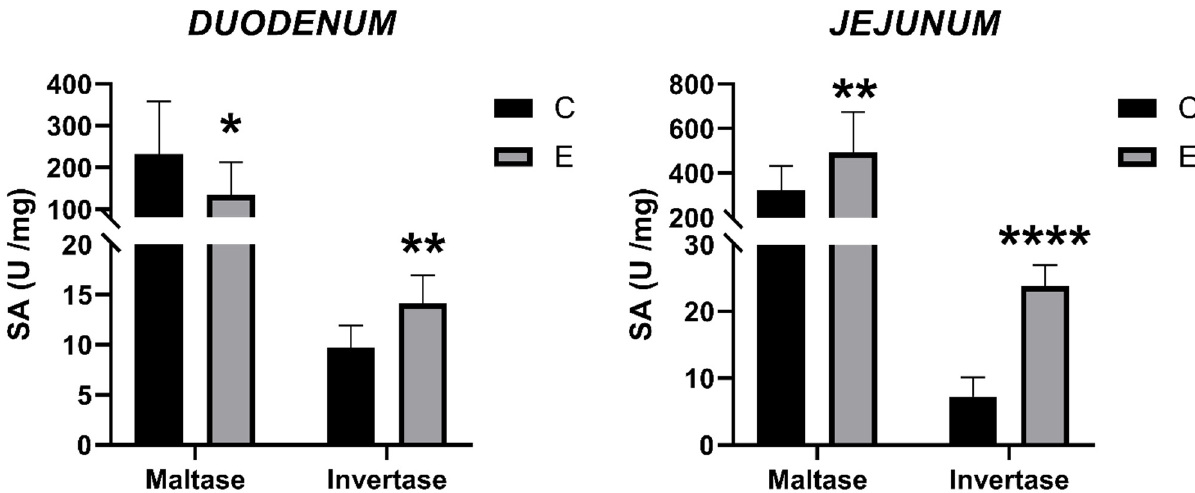
Figure 3. Effect of flaxseed meal supplementation to the basal diet of broiler chickens on the enzymatic specific activity (SA) of maltase and invertase, expressed as units per milligram of protein, from the duodenum and jejunum mucosa. All data are reported as mean values ± standard deviation (SD), and statistical significance is indicated as follows: * p ≤ 0.05; ** p ≤ 0.01; **** p ≤ 0.0001 ( n = 10).